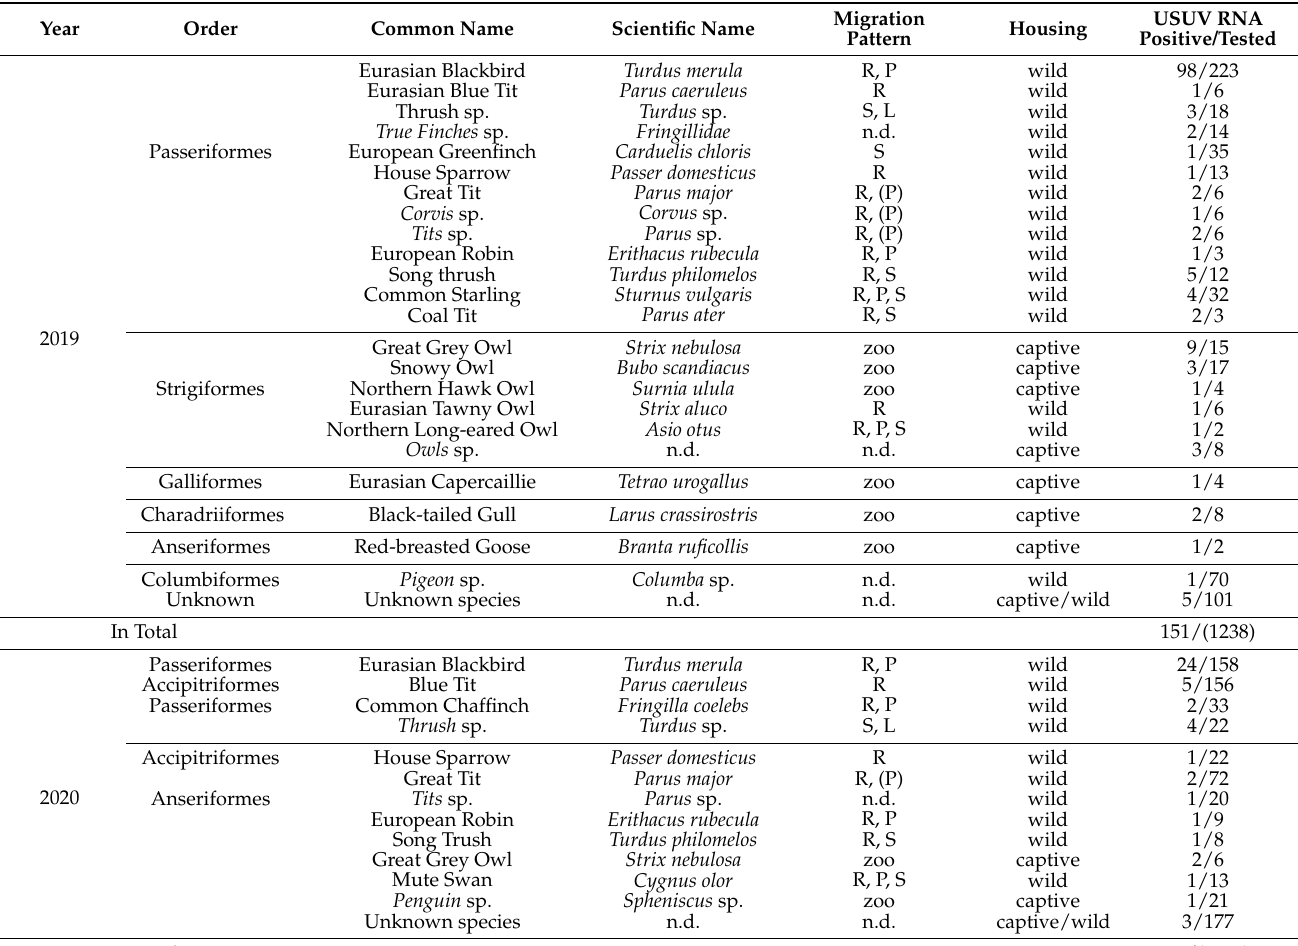
Table 3. Detailed information about bird species affected by USUV in 2019 and 2020 from the second panel (deceased birds/bird